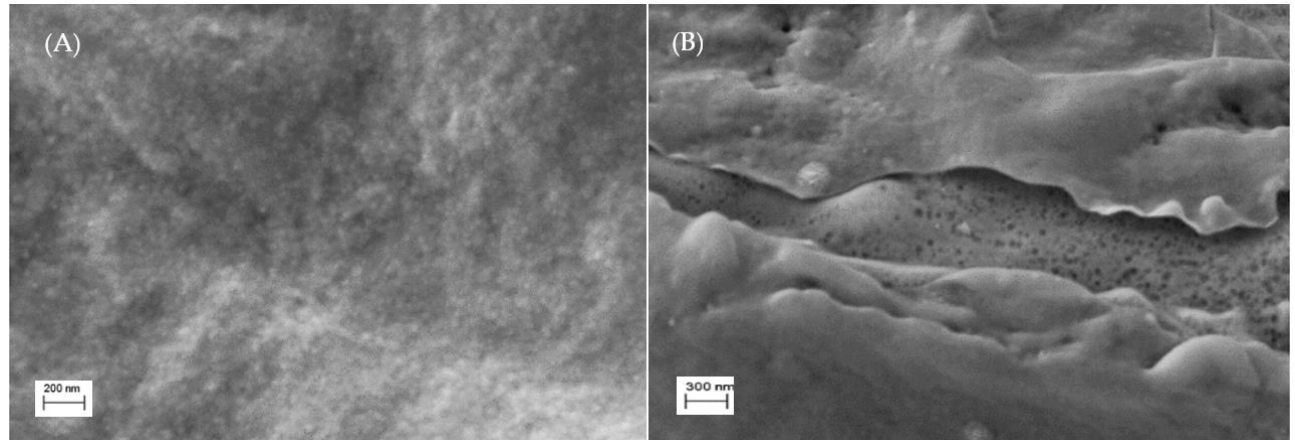
Figure 3. SEM morphology images of the surface of the chitosan ( A ) and 4–CH–SO 3 H material ( B ).